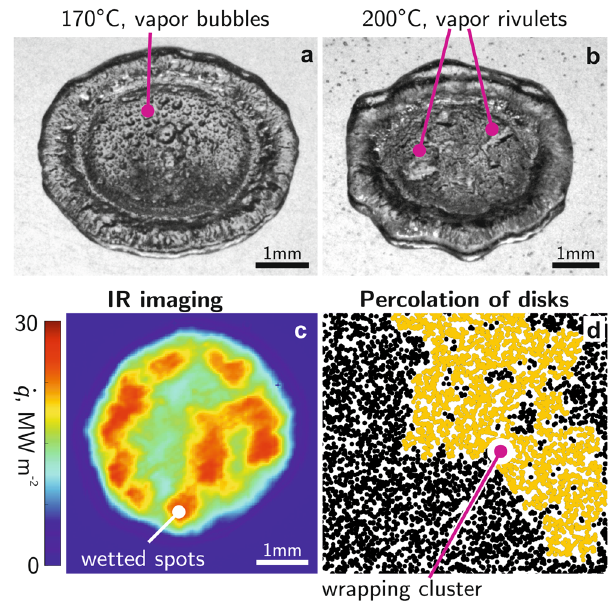
Fig. 4 Boiling of the liquid lamella on a hot substrate. a Spreading of a drop on a polished aluminum substrate at a initial substrate temperature T = 170°C in the delayed rebound regime, captured by the high-speed wall video system from the top. Bubbles are the result of the heterogeneous nucleation at the substrate. b Appearance of the percolating vapor rivulets during spreading of a drop on a polished aluminum substrate at T wall = 200°C. This impact leads to a non-sticking rebound. c Heat fl ux map, computed using the images captured using the high-speed infrared camera during drop impact onto a sapphire target at T wall = 378°C, corresponding to the non-sticking rebound accompanied by the intensive generation of fi ne secondary drops. The red regions of peak heat fl ux correspond to the substrate wetting. d Visualization of a continuum percolation with randomly distributed disks at a cumulative disk area λ = 1.2, slightly above the percolation threshold λ = 1.128. Each disk represents a simpli fi ed nucleation bubble. Above the c percolation threshold, the bubbles wrap to large clusters as marked by the orange color in d and shown in b and c